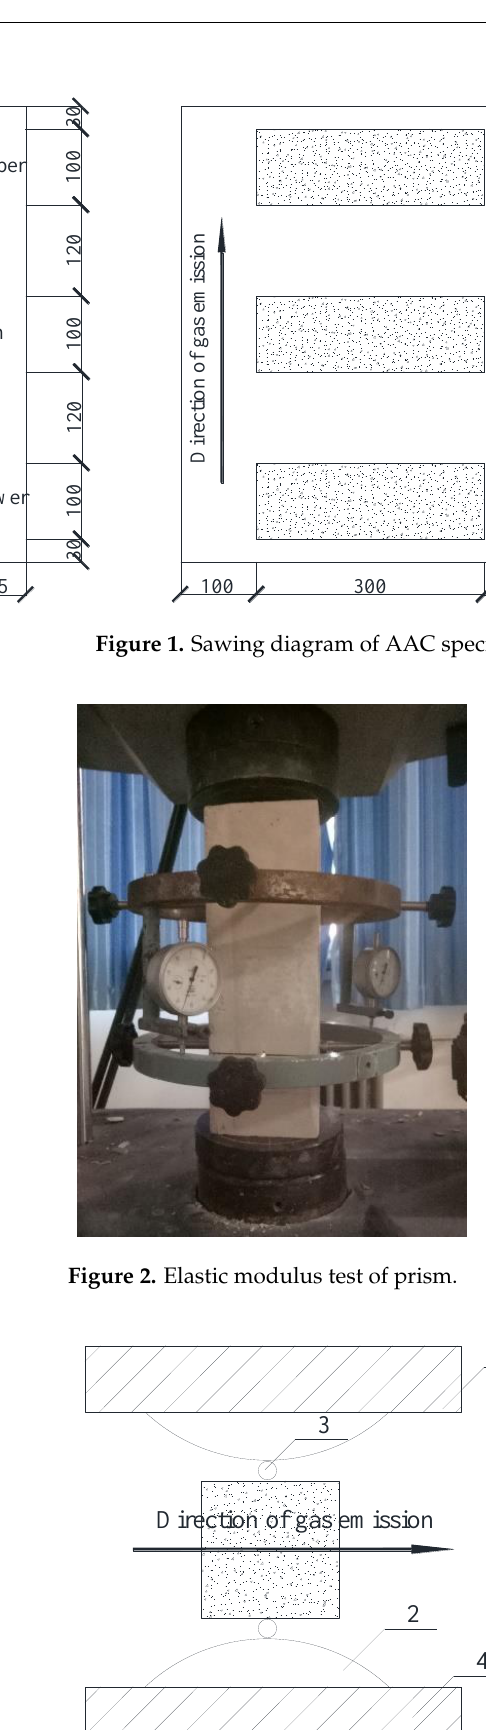
Figure 4. Flexural strength loading device. (Units in mm). 4. Pore Structures 4.1. Compositions Observed by SEM and XRD The SEM images of B04, B05, B06FA, and B06S AAC are shown in Figure 5. In the figure, the form and strength of hydration products of AAC with different mix proportion are compared. It can be seen that tobermorite in B04 AAC was mainly needle-like, mainly lapped together, about 1–2 μm long, with less hydration products, more pores, and the lowest strength; tobermorite in B05 and B06FA AAC was willow-like, 1 μm wide, and 2– 3 μm long, and the crystal form of the hydration product was well developed. Compared with B04 AAC, there were more hydration products in B05 AAC; the hydration products of B06FA were interlaced to form a whole body with relatively high strength. Tobermorite in B06S AAC was sheet-like and about 2 μm long, the hydration products were cross- linked with each other, forming a dense network structure with the highest mechanical strength.